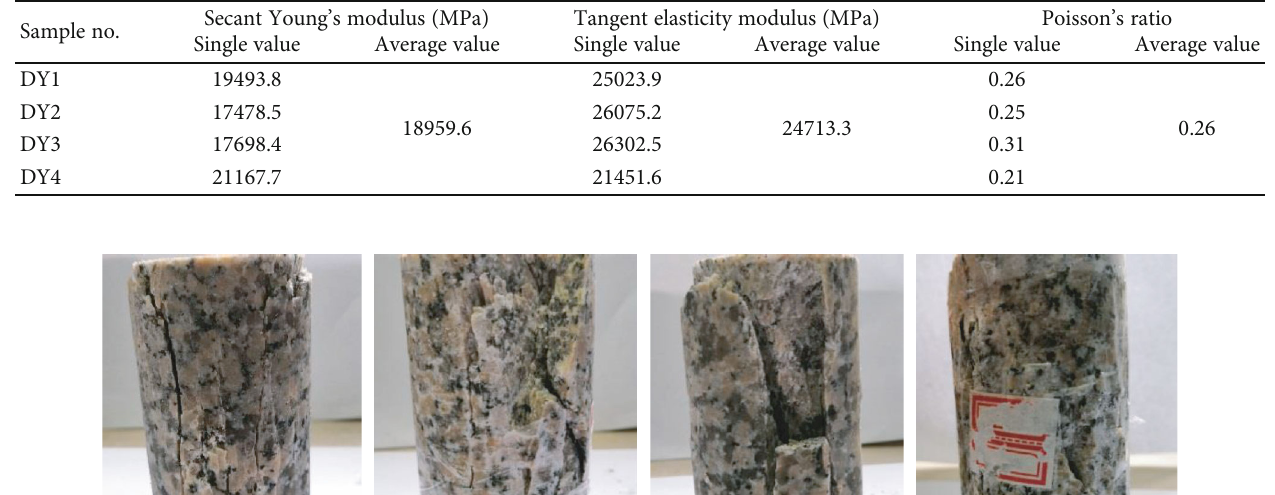
Table 2: Deformation characteristics of granite samples.